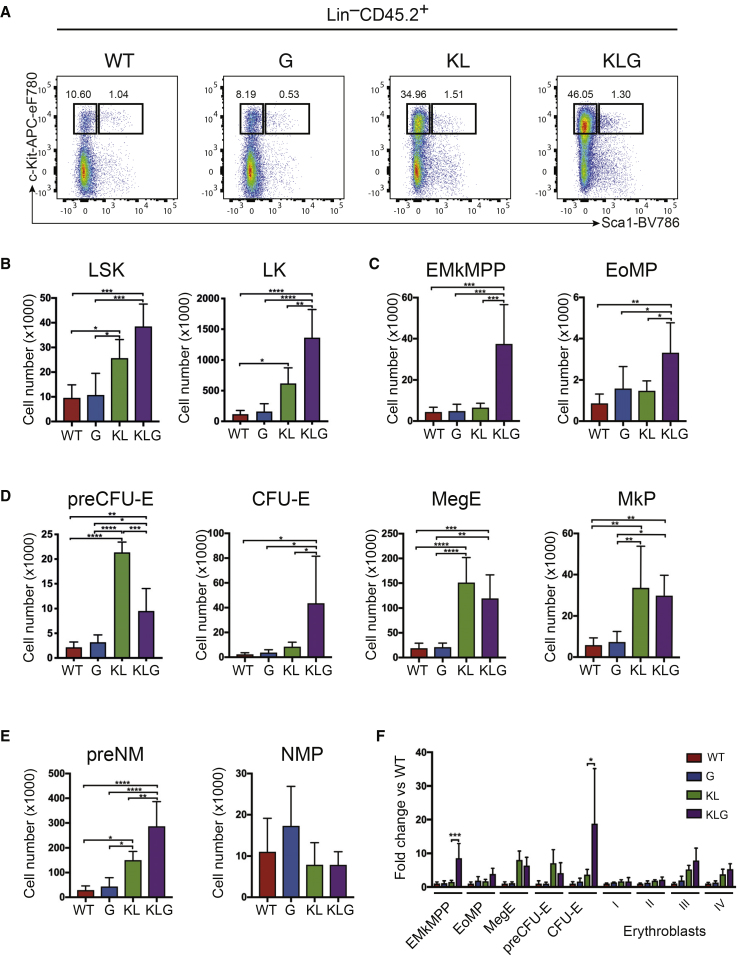
Mutation of GATA-2 ZnF1 Impairs Differentiation at Distinct Stages on Myelo-Erythroid Differentiation(A) Representative FACS plots LSK and LK cells in the BM in pre-leukemic mice 6 weeks post-transplantation.(B) Absolute number of LSK (left panel) and LK cells (right panel) in the BM in mice from (A).(C) Absolute number of phenotypic EMkMPP (left panel) and EoMP progenitors (right panel) in the BM in mice from (A).(D) Absolute number of phenotypic committed erythroid/megakaryocytic progenitors in the BM in mice from (A).(E) Absolute number of phenotypic committed neutrophil-monocyte progenitors in the BM in mice from (A).(F) Number of myelo-erythroid progenitors from (C and D) and stage I–IV erythroblasts normalized to WT values in mice from (A). Myelo-erythroid progenitor analysis was performed on five to six replicates from two independent experiments. Stage I–IV erythroblast analysis was performed on three to four replicates from one experiment. The results were analyzed using a multiple comparison ANOVA. The results are presented as the mean ± SD. ∗p < 0.05, ∗∗p < 0.01, ∗∗∗p < 0.001, ∗∗∗∗p < 0.0001.